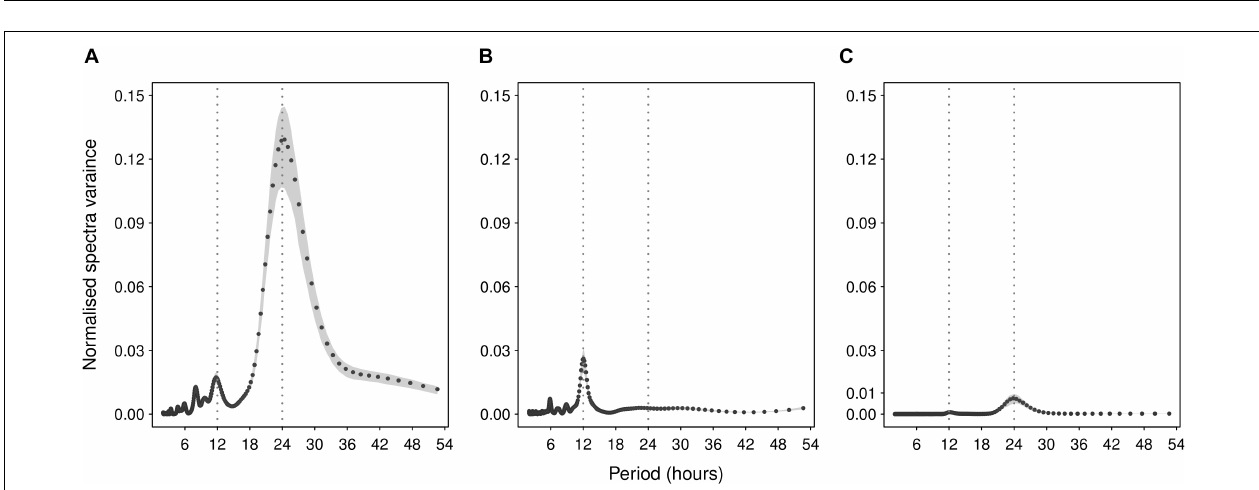
FIGURE 1 | Consort diagram. Flow diagram showing the enrollment of subjects and the variables that were measured in each study, and for the current pooled analysis.